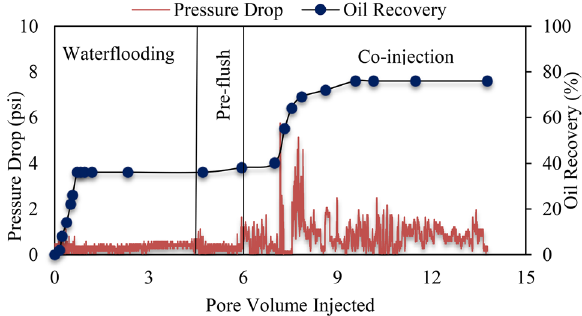
Fig. 4 Oil recovery following waterflooding and foam injection for surfactant, non-fractured rock